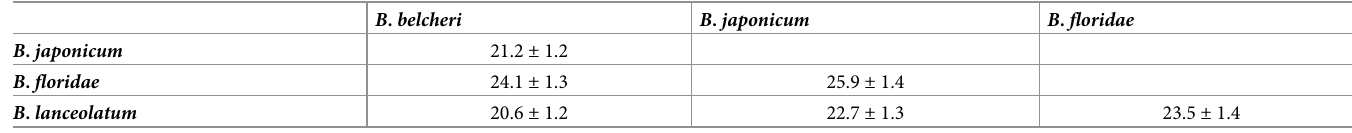
Values reported as percentage ± mean standard